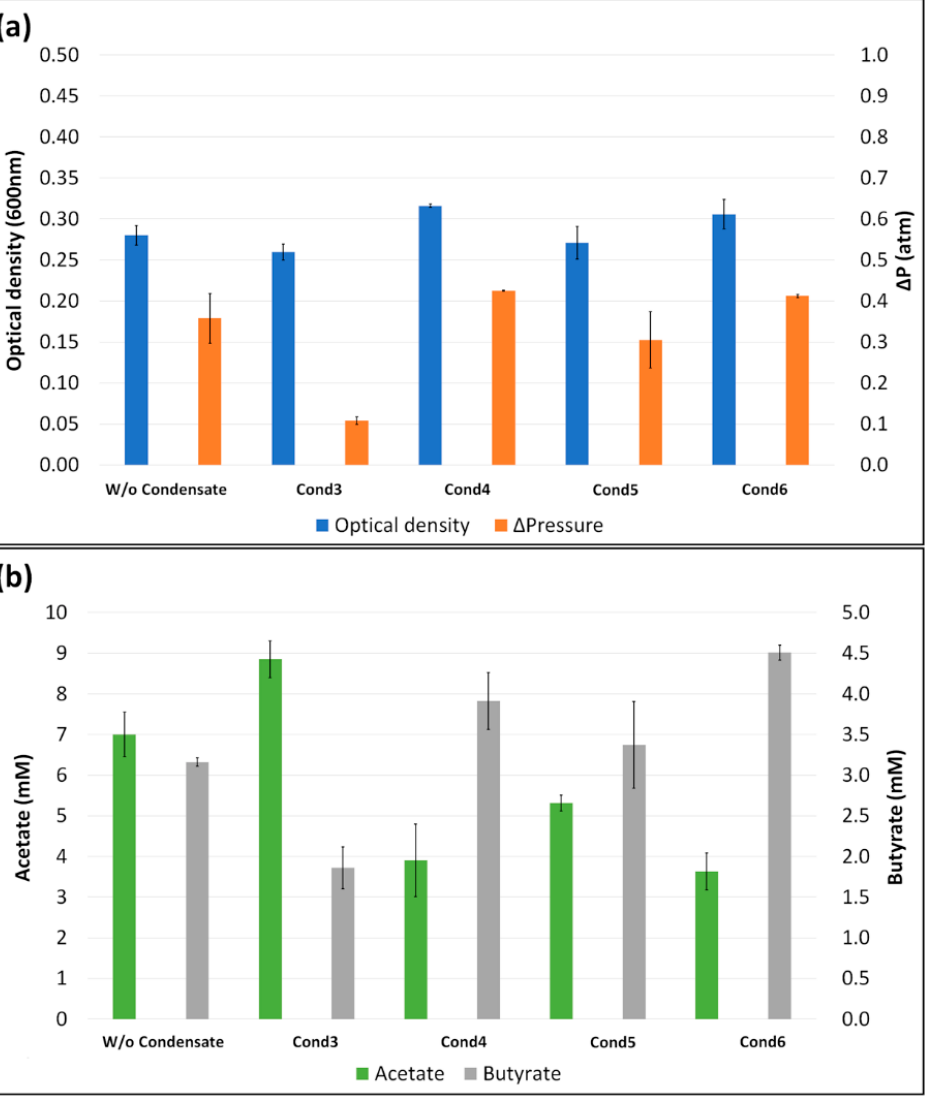
Figure 6. Optical density and pressure variation ( Δ P) ( a ), and acetate and butyrate production ( b ) by B. methylotrophicum at 72 h while growing from syngas in the absence or presence of syngas condensates Cond3 to Cond6, obtained during the gasification of WST using different catalysts.